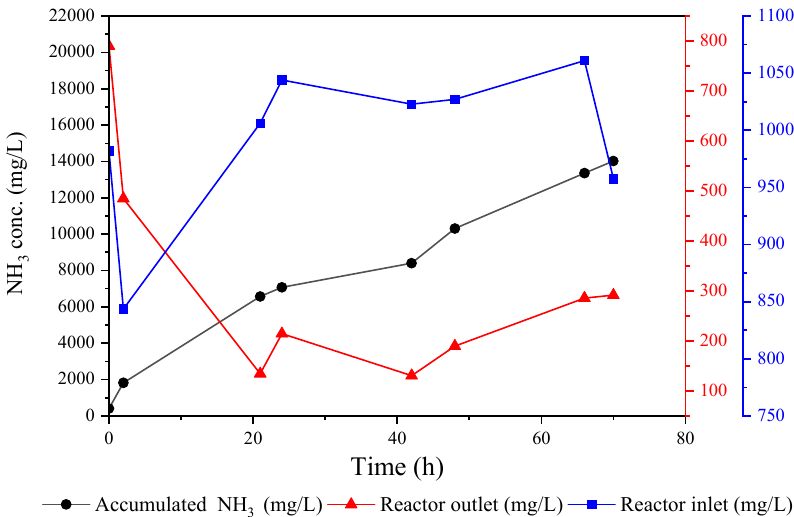
Figure 5. Ammonia concentration profile for contactor and acid tanks throughout the testing period.